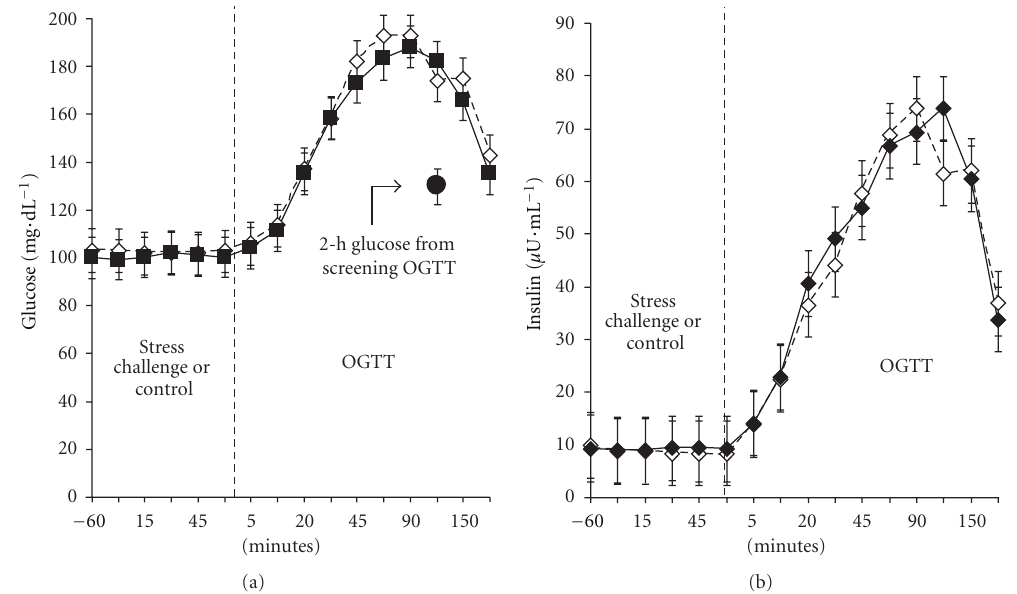
Figure 3: Glucose and insulin responses over the experimental period and the OGTT between the stress (solid line) and control (broken line) conditions. Data are mean ± se; N = 17. To convert to the International System of Units (mmol), multiply glucose values by 0.055.